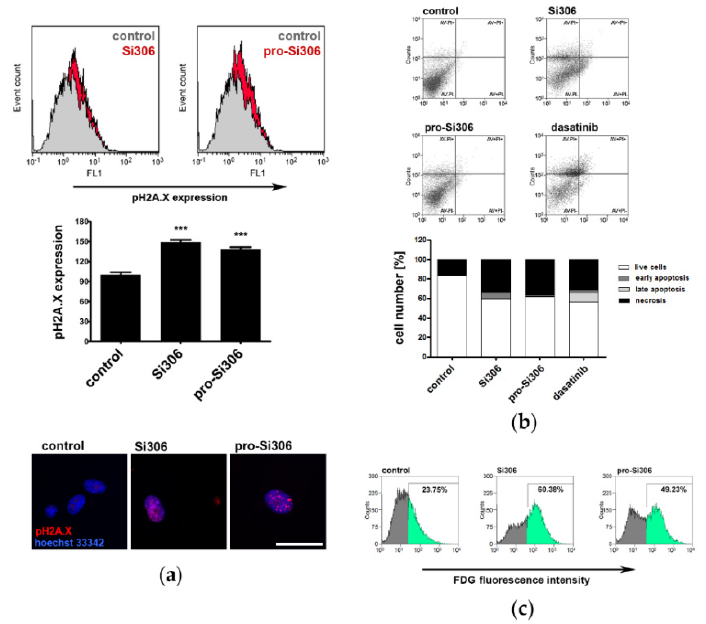
Figure 5. Si306 and pro-Si306 induce DNA damage, cell death and senescence in primary glioblastoma cells. ( a ) Representative flow-cytometric profiles of phospho-histone H2A.X (pH2A.x) expression in GBM-6 cells after 24 h treatment with 10 µ M Si306 and pro-Si306 (upper panel). The histogram shows mean fluorescence intensity obtained by flow-cytometric detection of cells immunolabeled with pH2A.x antibody (middle panel). Values are expressed as mean ± SEM. Statistical significance between treated and control group is shown as *** ( p < 0.001). Representative fluorescent micrographs of GBM-6 cells labeled with phospho-histone H2A.X antibody (red) and hoechst 33342 (blue) after 24 h treatment with 10 µ M Si306 and pro-Si306 (bottom panel). Scale bar = 100 µ m. ( b ) Cell death in GBM-6 cells was evaluated by AV/PI staining after 72 h treatment with 10 µ M Si306, pro-Si306 and dasatinib. Representative flow-cytometric profiles of AV/PI stained cells for each condition are presented (upper panel). AV fluorescence was read on the FL1 green channel and PI fluorescence was read on the FL2 red channel. The histogram shows the percentage of viable (AV − PI − ), early apoptotic (AV+ PI − ), late apoptotic (AV+ PI+) and necrotic (AV − PI+) cells after treatment (bottom panel). ( c ) β -galactosidase activity in GBM-6 cells was evaluated by flow-cytometric measurement of FDG fluorescence after 48 h treatment with 10 µ M Si306 and pro-Si306. Percentages in the representa- tive flow-cytometric profiles show the number of senescent cells. The region of interest (green) was set to include approximately 20% of FDG-positive cells in the control